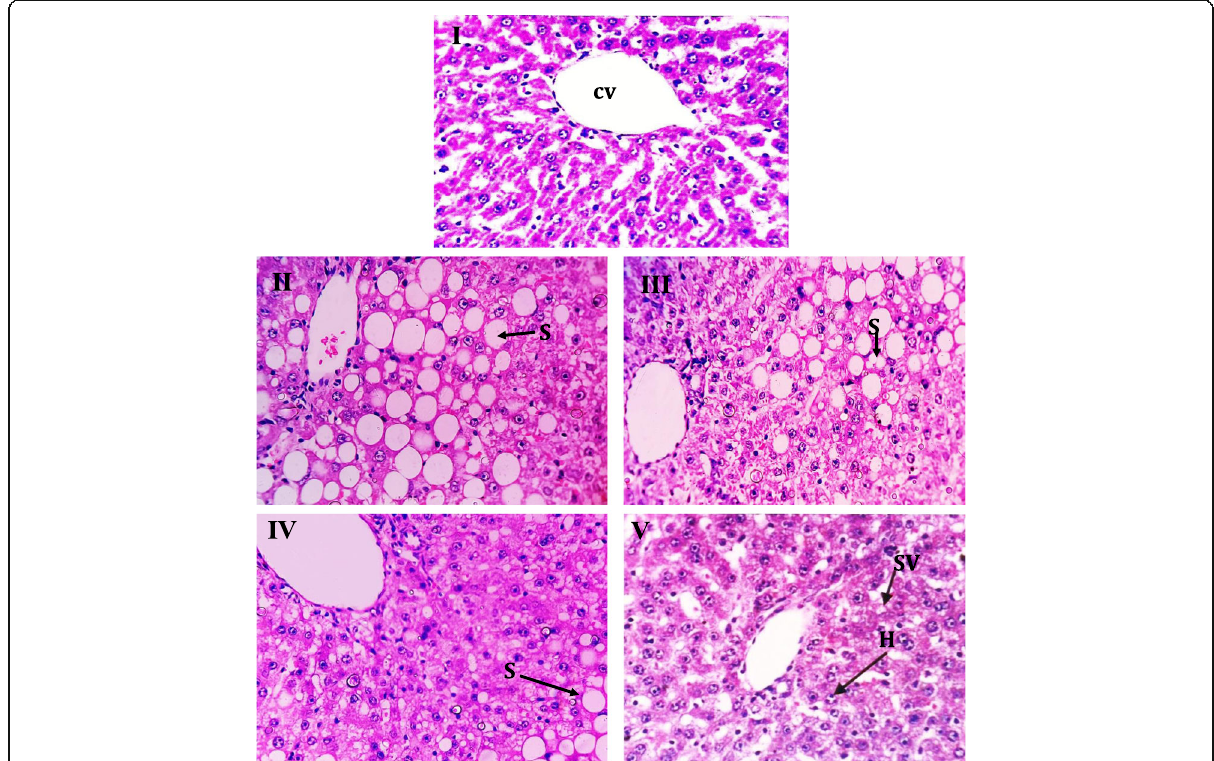
Fig. 3 Histological examination of the hepatic tissue of all experimental rats, at the end of experiments. I: Control rats, II: rats fed HFD without supplements, III: rats fed HFD + supplements, IV: rats fed HFD + supplements + 400mg chitosan and V: rats fed HFD + supplements + 800mg chitosan. CV: central vein, H: hepatocyte, S: steatosis (fat accumulation), and SV: slight vacuolation. Haematoxylin & Eosin, X